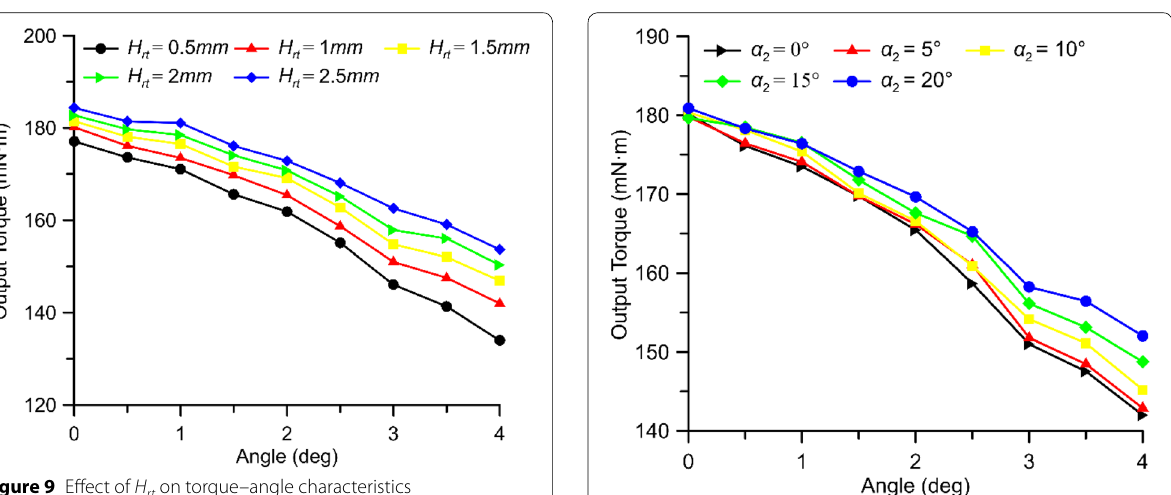
Figure 11 Effect of α 2 on torque–angle characteristics